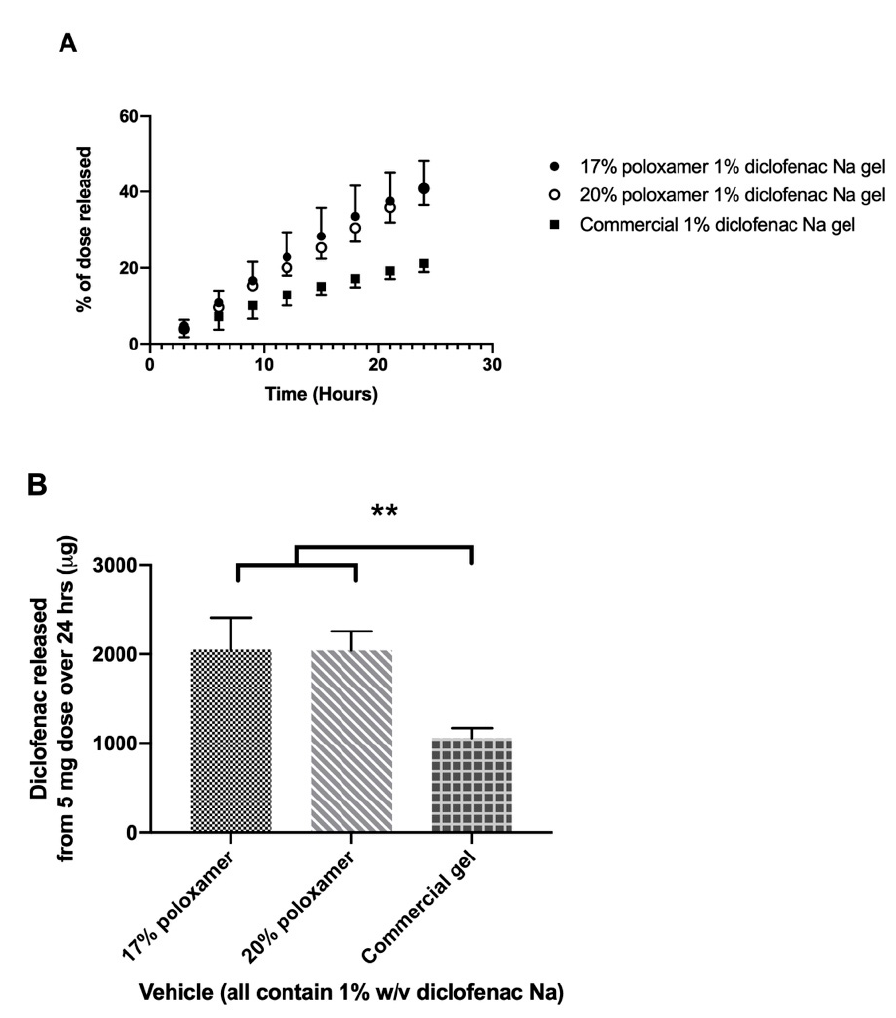
Figure 5. In vitro drug release study using a Snakeskin ® dialysis membrane. ( A ) Percent of the initial 5 mg dose released from each formulation over 24 h. ( B ) Total mass of diclofenac sodium released from each formulation over 24 h. Data presented as mean ± SD ( n = 3). ** p ≤